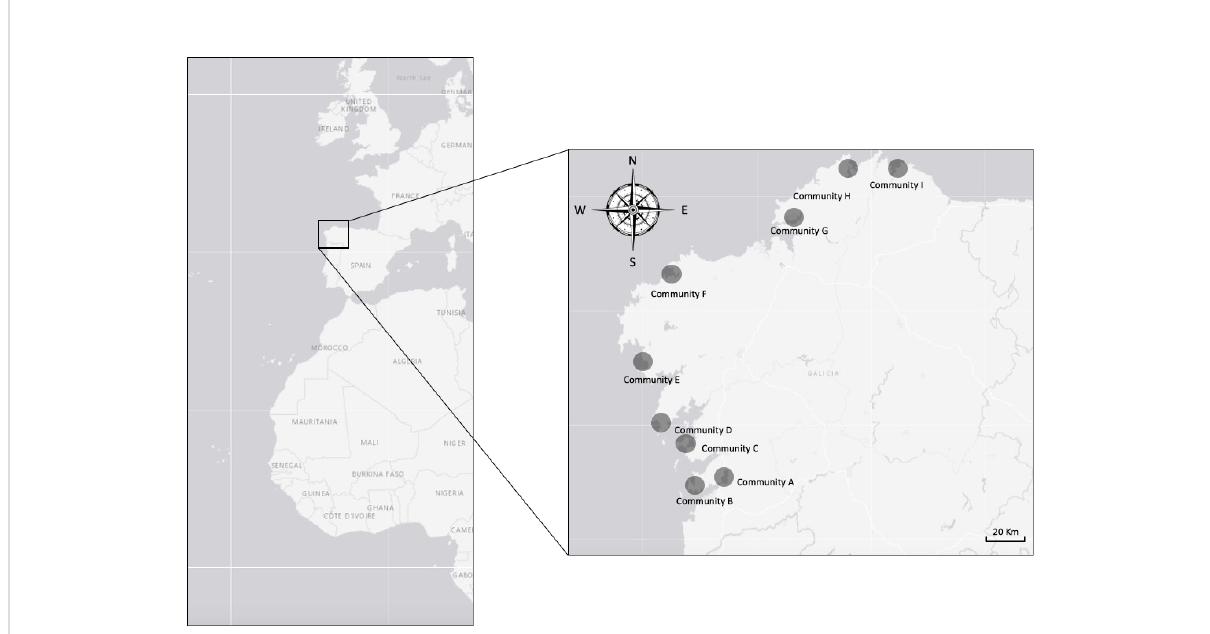
FIGURE 1 Map of the study region in Galician, Spain (left), and the nine small-scale fi sheries communities